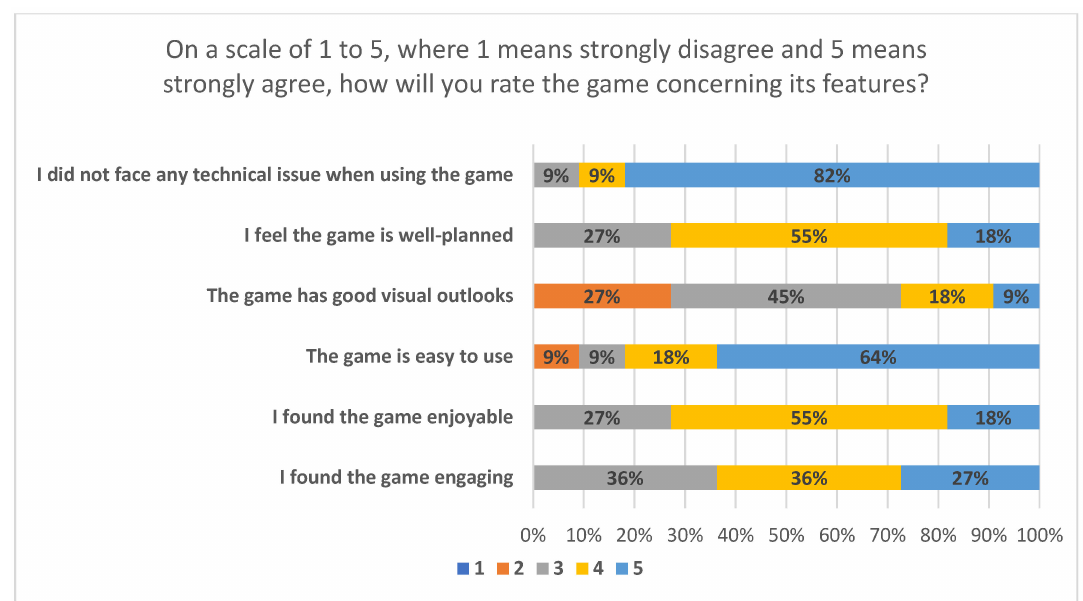
Figure 12. Respondents’ rating concerning the game’s functionalities and